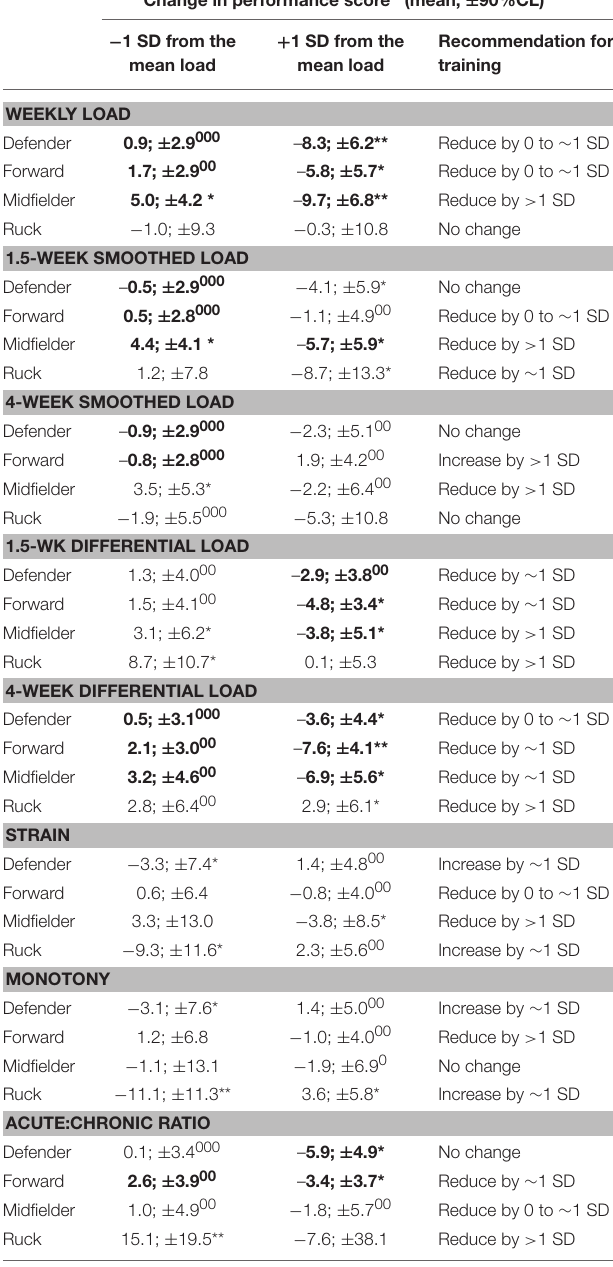
TABLE 1 | Descriptive statistics of performance score and training measures for the playing-position groups. Data presented as mean ± within-player SD. Defender Forward Midfielder Ruck